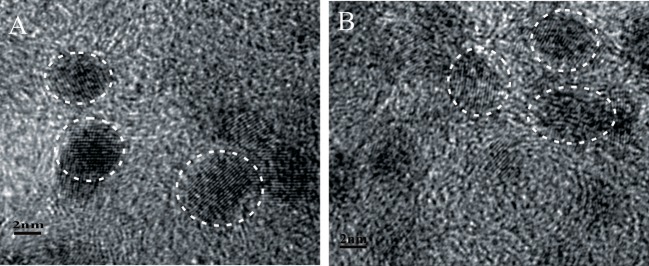
Representative HRTEM images of the catalyst particles of (A) Pd2Co/C and (B) Pd2/Co-nanofilms/C.